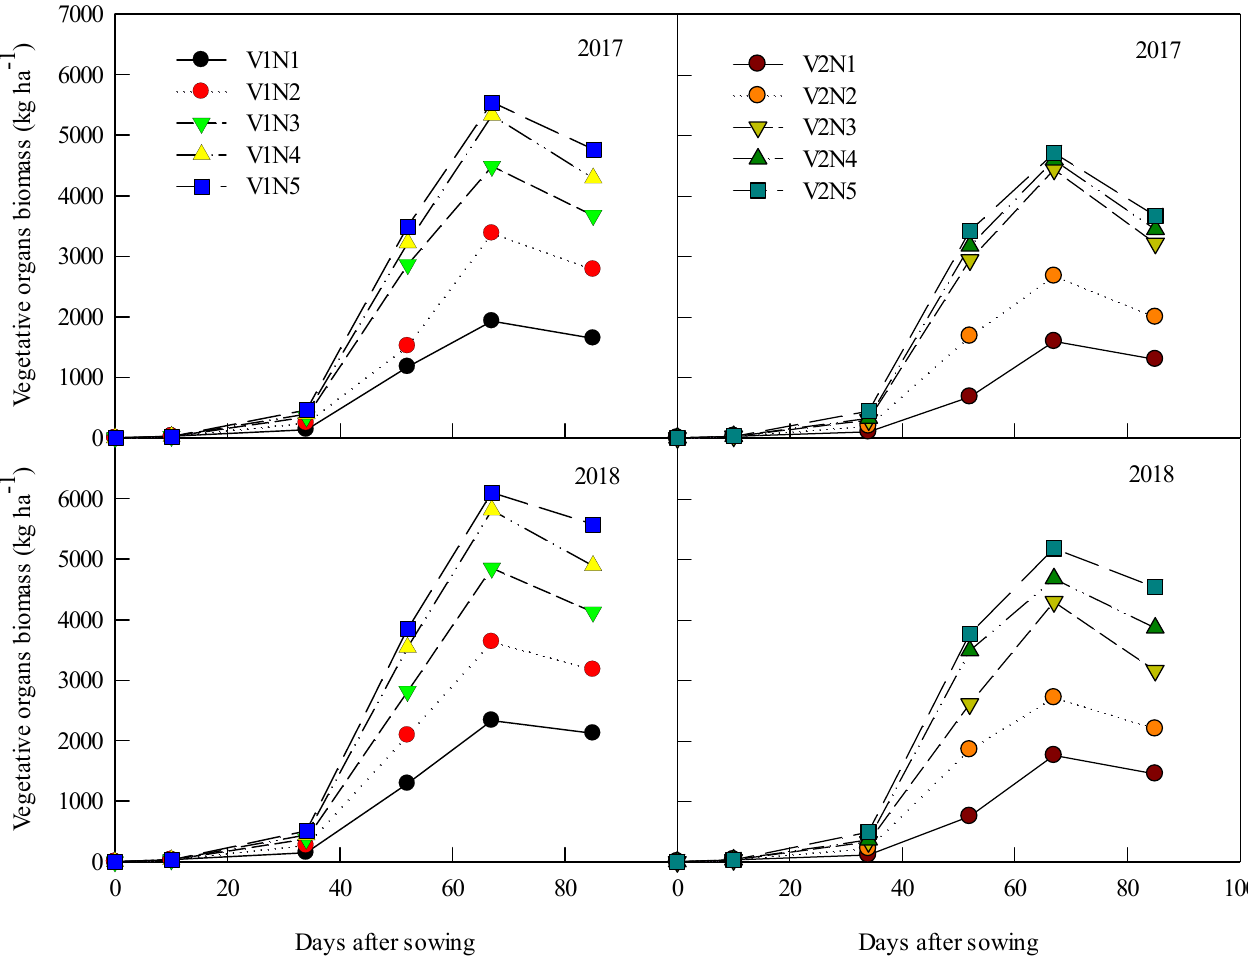
Figure 2. Changes in vegetative organ biomass yield in response to nitrogen fertilization and variety in 2017 and 2018. (n = 3). V1 and V2 represent FM hybrid (Zhangzagu 8) and FM local variety (Bagu 214), respectively, while N1, N2, N3, N4 and N5 represent nitrogen application rates at 15, 61.7, 108.4, 155.1 and 201.8 kg ha − 1 , respectively.